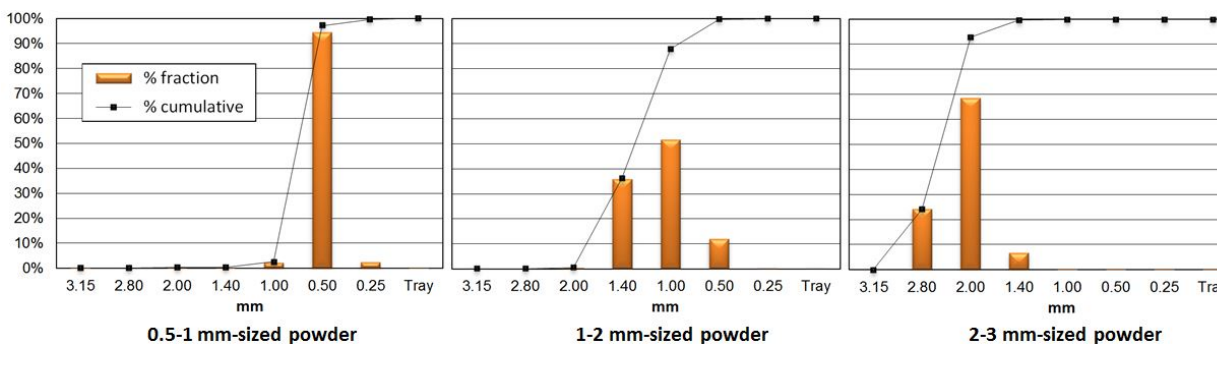
Figure 4. Granulometric analysis of original